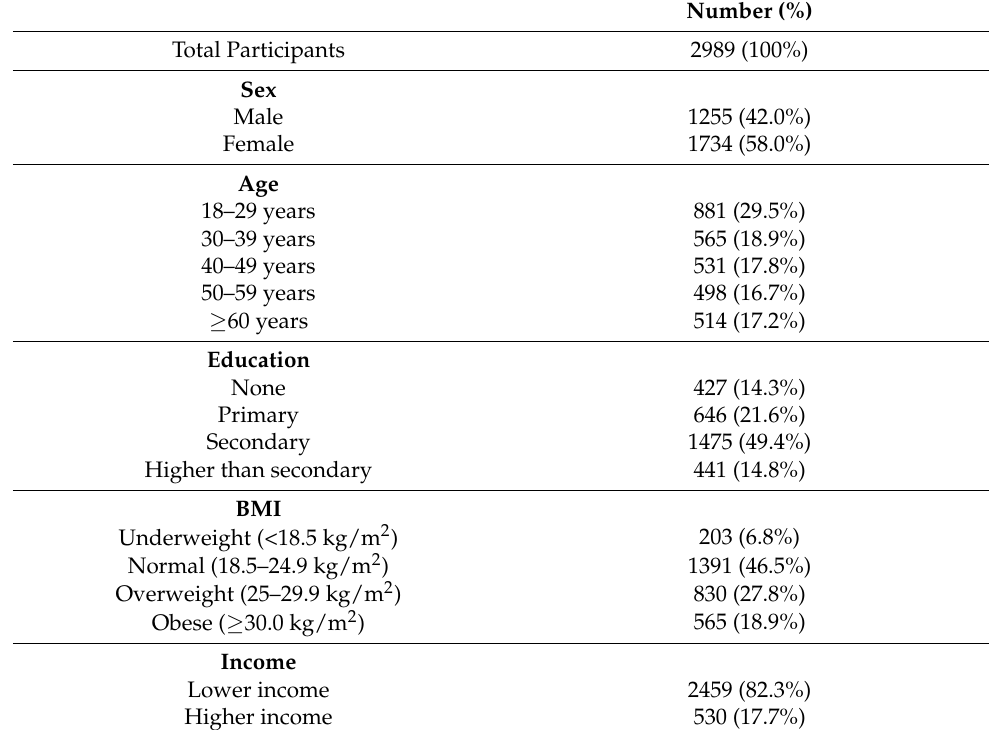
Table 2. Sociodemographic characteristics of study participants.